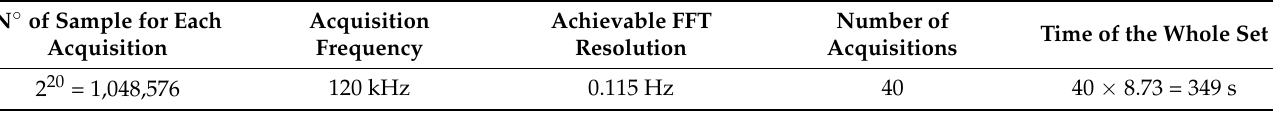
Table 3. Characteristics of each set of